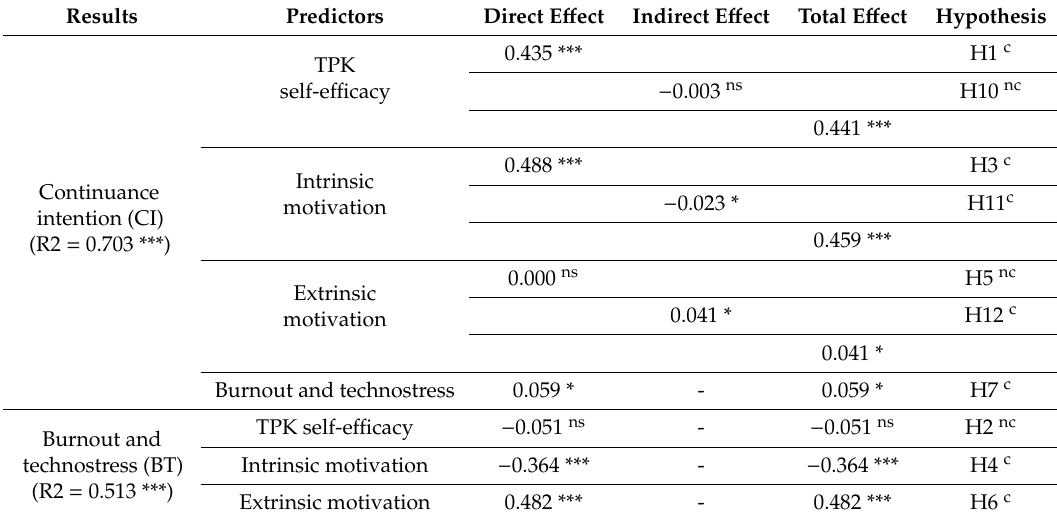
Figure 4. Model of continuance intention to use online instruction. Only significant hypotheses are represented. Table 3. The summary of the causal effects’ hypothesis of the structural model .